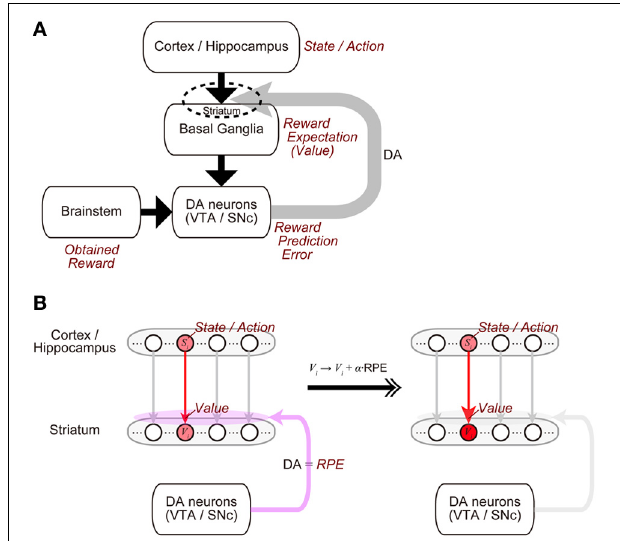
FIGURE 1 | Mutual interaction between dopamine (DA) and the cortico-basal ganglia (CBG) circuits, and its suggested functional counterpart. (A) DA neurons in the ventral tegmental area (VTA) and the substantia nigra pars compacta (SNc) receive major inputs from the basal ganglia (BG) and the brainstem. In turn, DA released from these neurons induces plastic changes of synapses in the CBG circuits, in particular, corticostriatal synapses (indicated by the dashed ellipse). This mutual interaction between DA and the CBG circuits has been suggested to implement the algorithm of reinforcement learning as follows. (1) States or actions are represented in the cortex or the hippocampus, and receiving inputs from them, neurons in the BG, in particular, medium spiny neurons in the striatum represent values (reward expectations) of the states/actions, with these values stored in the strengths of the corticostriatal synapses. (2) The DA neurons receive inputs from the BG, as well as inputs from the brainstem, which presumably convey the signal of obtained reward, and compute reward prediction error (RPE). (3) Then, released DA, representing the RPE, induces plastic changes of the corticostriatal synapses, which implement the update of the values (reward expectations) according to the RPE. (B) Presumed implementations of processes (1) and